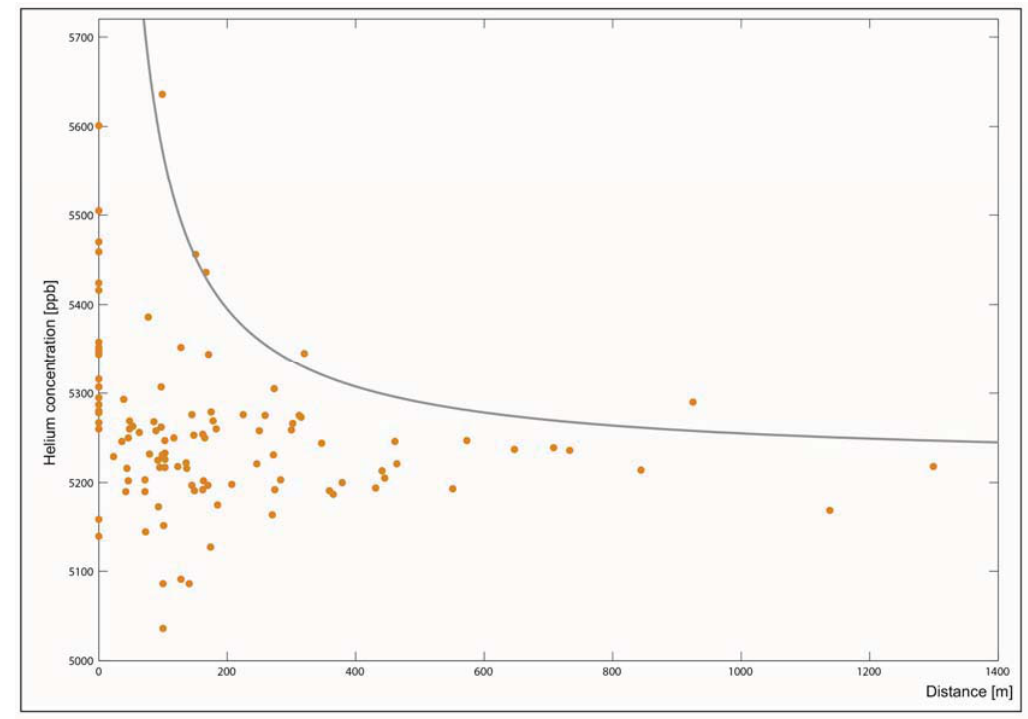
Figure 11. Helium concentration (ppb) versus distance (m) from the closest